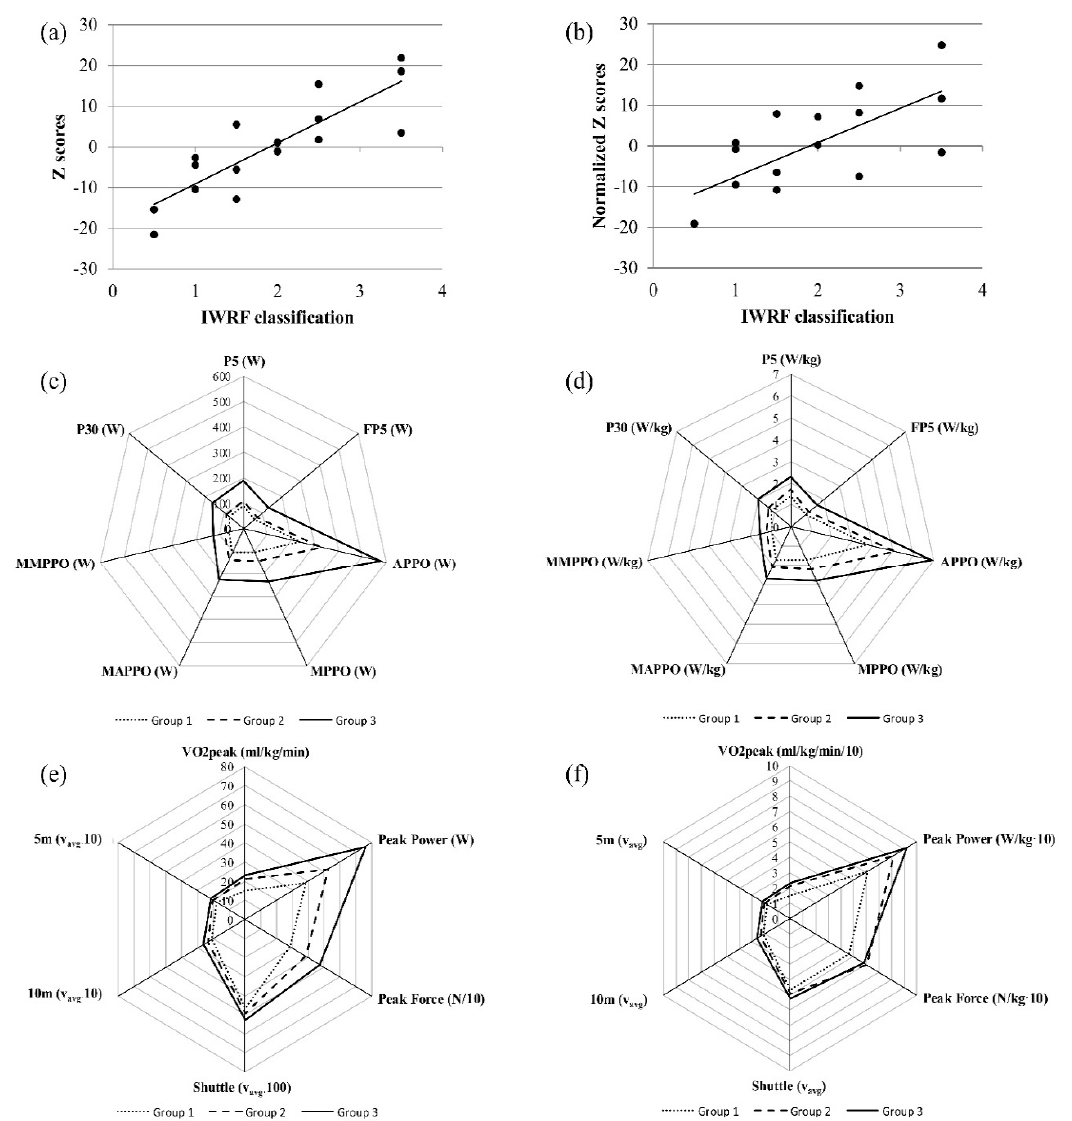
Figure 3. Z scores and permutation-based ranking analysis results. Absolute values are presented on the left ( a , c , e ); body mass normalized values are presented on the right ( b , d , f ). (VO 2 peak, peak of the oxygen consumption; P5, highest mean power over a successive 5-second interval; P30, mean power over 30 s; FP5, mean power of the last 5-second interval; APPO, absolute peak power output in the first 5 s; MPPO, minimum peak power output in the last 5 s; MAPPO, integral mean of the power signal over thrusts including APPO; MMPPO, integral mean of the power signal over thrusts including MPPO).